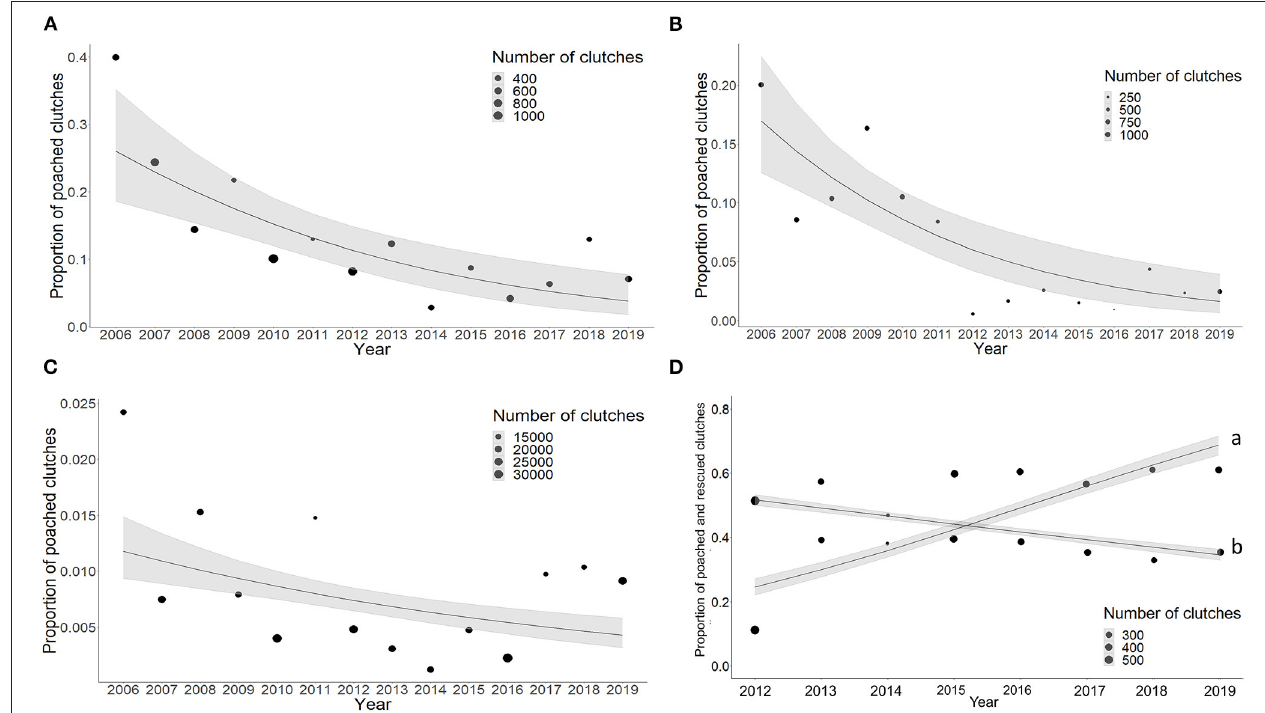
FIGURE 4 | Annual decrease in percent of poached clutches at each study site. The shaded areas indicate the standard error. (A) Playa Norte, (B) Tortuguero leatherback season, (C) Tortuguero green season, (D) Pacuare, (a) proportion of rescued clutches, (b) poached clutches. Point size indicates the number of clutches laid on that mile of beach. Solid line indicates the model fit, grey shaded areas are 95%